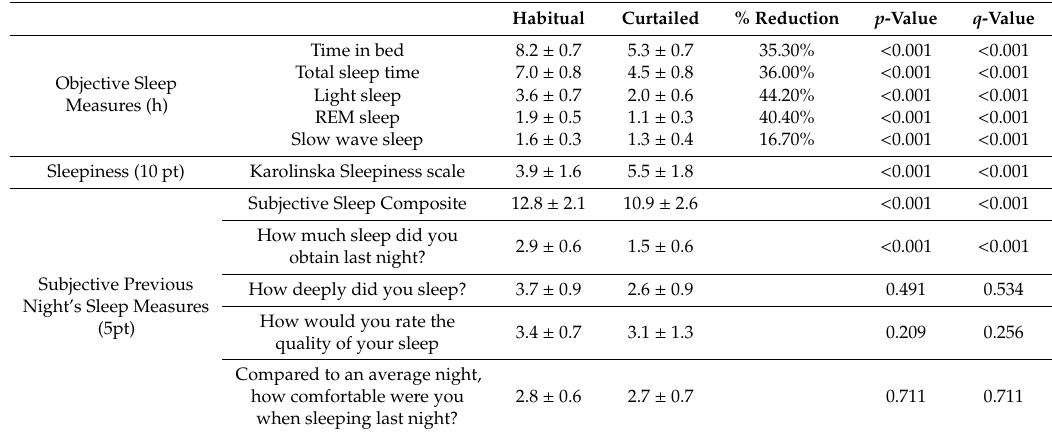
Table 2. Summary of objective and subjective sleep measures.